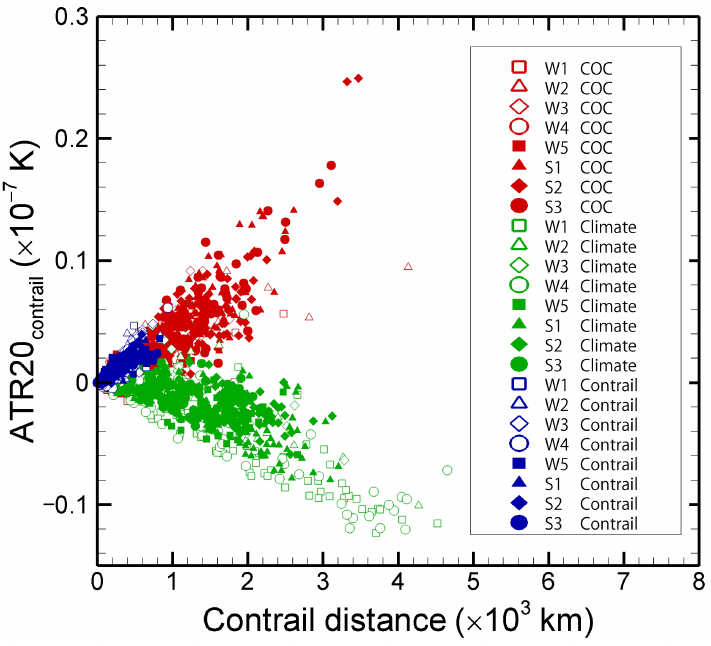
Figure 8. Contrail distance vs. ATR20 contrail for 103 individual flights obtained by the COC, the contrail and the climate options for the respective weather